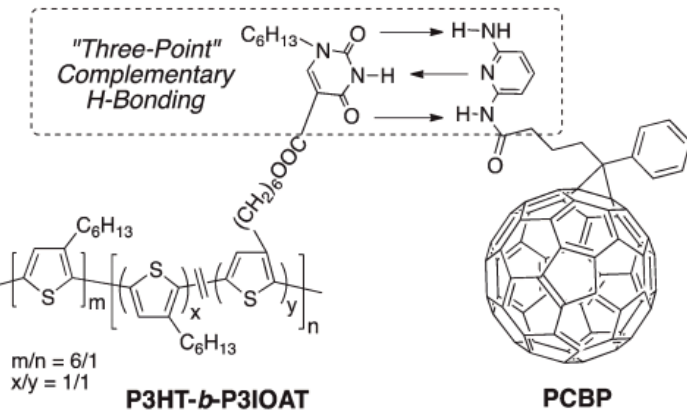
Figure 12. Structure of copolymer donor P3HT- b -P3IOA and fullerene acceptor PCBP, along with the three-point hydrogen bonding between the compounds. Reproduced from [141] with permission from The Royal Society of